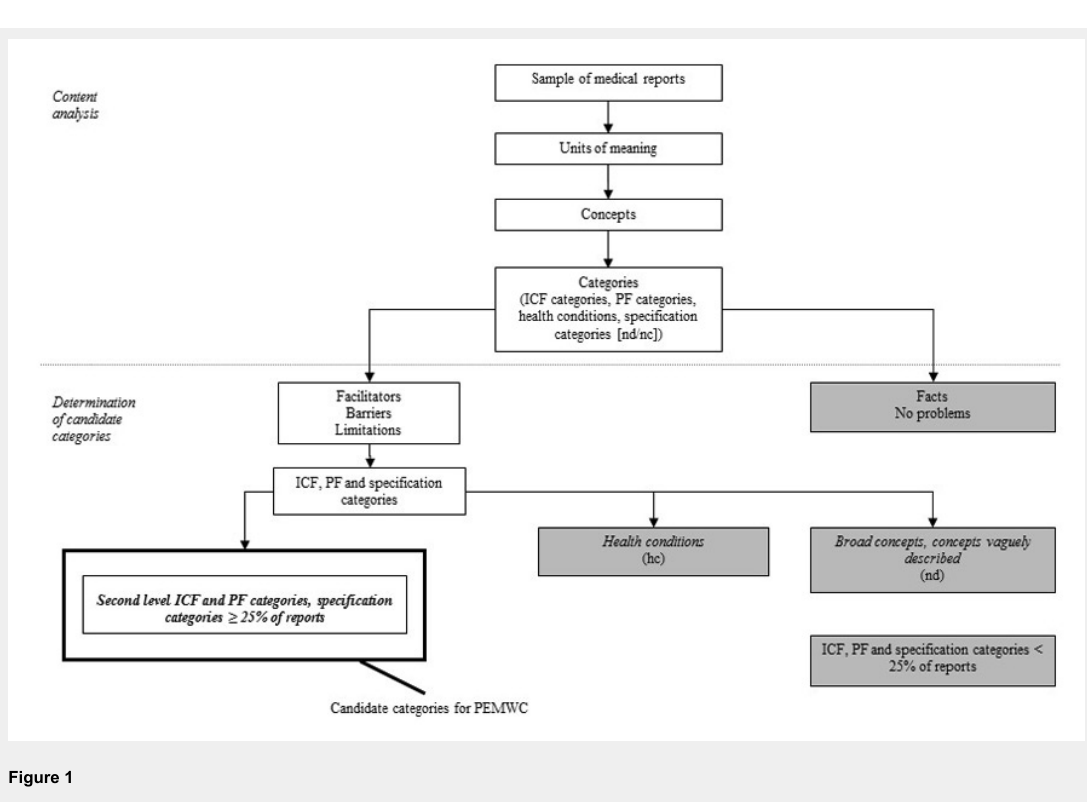
Overview of the selection process for the candidate categories. PF = personal factor; hc = health conditions; nd = not definable with the ICF; nc = not covered by ICF; boxes shaded in grey refer to concepts that were excluded in the selection process for the candidate